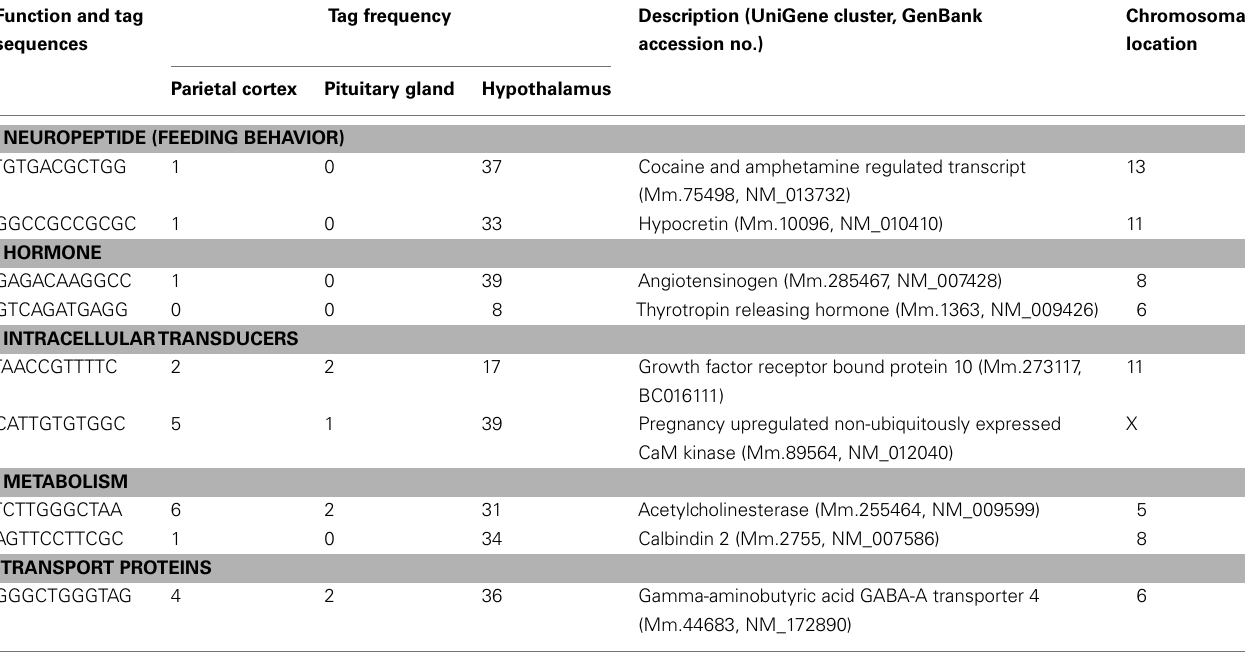
Table 1 | Components of cell signaling and communication preferentially expressed in the